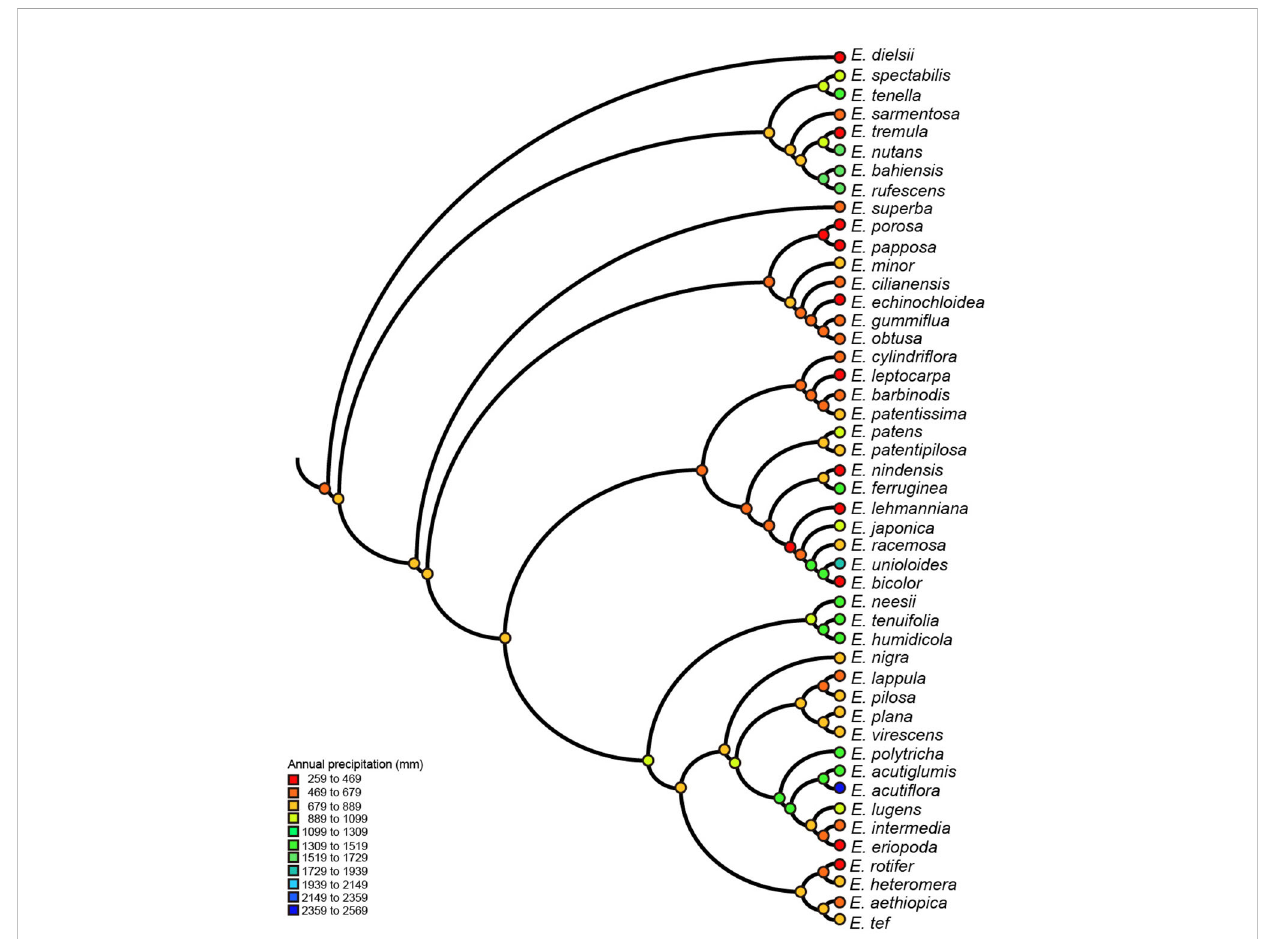
FIGURE 3 Parsimony reconstruction of ancestral annual precipitation (mm) on Eragrostis consensus tree (balls & sticks). Different values of precipitation were marked as different